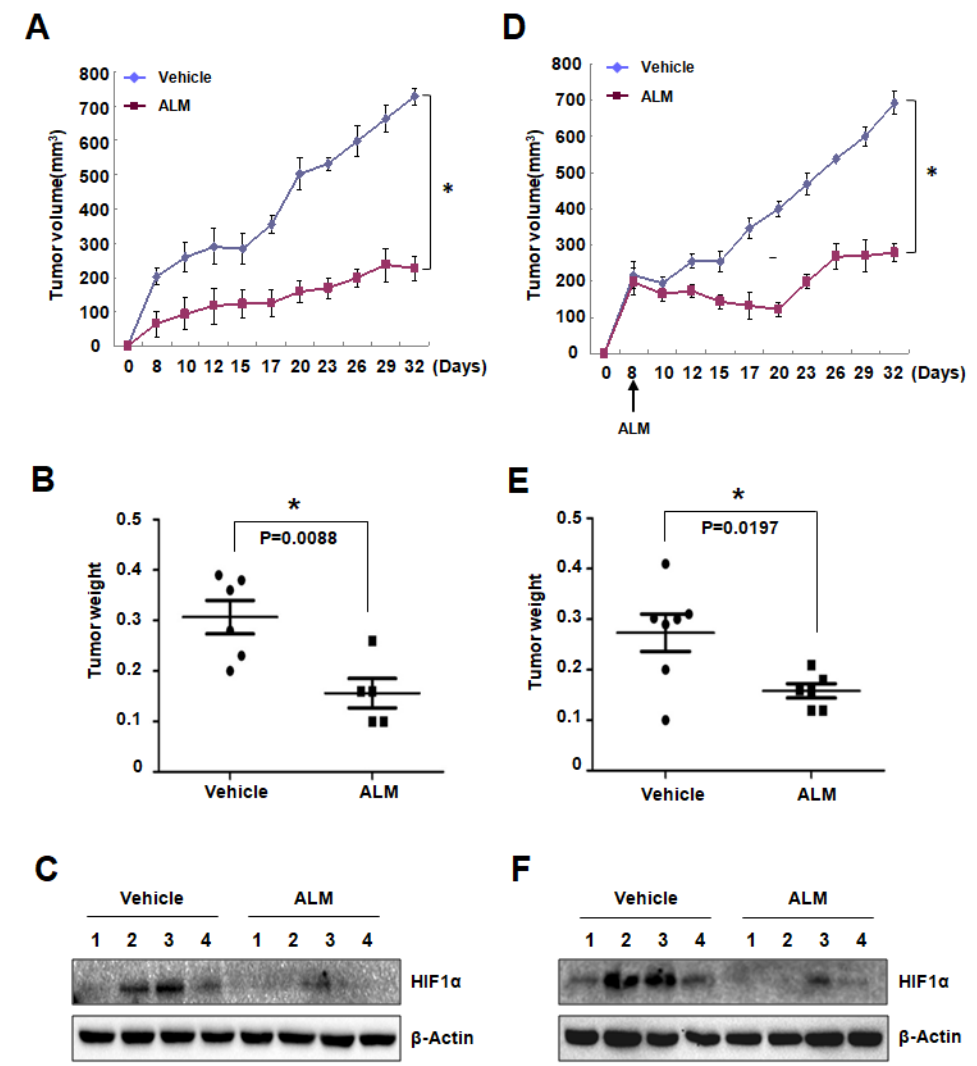
Figure 4. ALM treatment inhibited PC3 xenograft growth. ( A , D ) BALB / C Nude male mice were implanted with PC3 cells in subcutaneous tissue on the flank. Mice were treated with daily i.p injection of ALM (10mg / kg body weight, n = 5) / vehicle ( n = 6) starting from 7 days before tumor cell implantation. Tumor volume was determined from day 8 to day 32 ( A ). PC3 cells were subcutaneously (s.c.) injected into BALB / c nude mice. 8 days after tumor inoculation, when the tumor volume reached about 200 mm 3 , mice started to be treated with vehicle (n = 7) or ALM (10 mg / kg body weight, n = 6). Tumor volume was determined from day 8 to day 32 ( D ). mean ± s.e.m. are shown; P < 0.0001 vs. vehicle (Student’s t -test). ( B , E ) Tumors were harvested and weighted after sacrificing mice (mean ± s.e.m.; P value is determined by Student’s t -test). ( C , F ) HIF-1 α and protein level was detected in tumor samples; * P < 0.05 compared between the indicated groups.